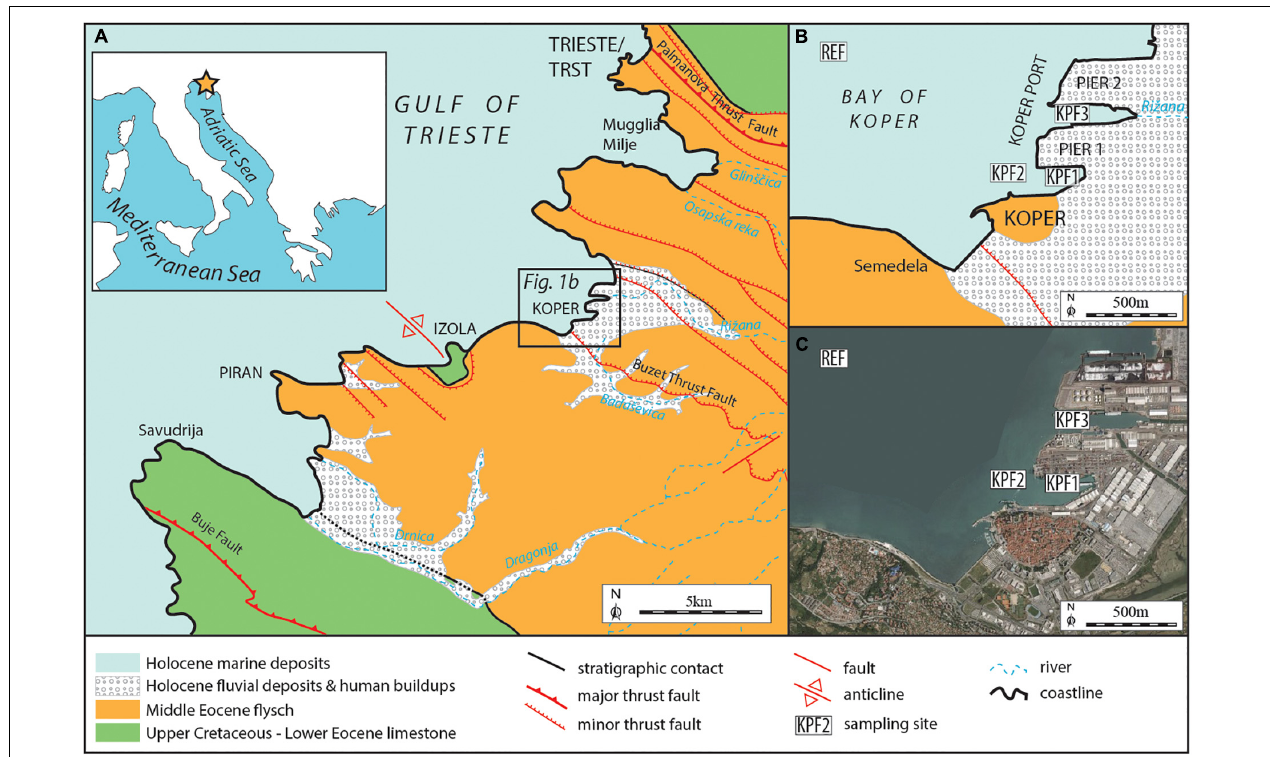
FIGURE 1 | (A) Geographical and geological map of investigated area. (B) Enlarged boxed area from Figure 1A with sampling locations. (C) Bay of Koper with sampling locations (http://gis.arso.gov.si/atlasokolja/).